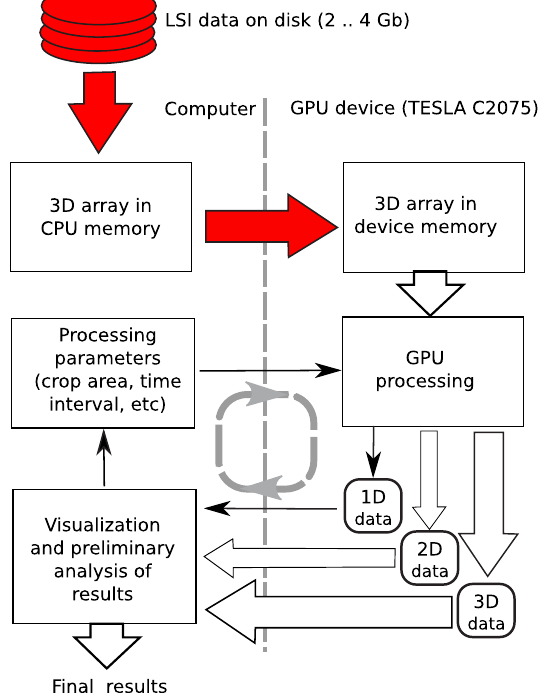
Fig. 1. A schematic illustration of GPU-based processing of large LSI data. The thicker arrows correspond to larger amount of data tra±c between CPU memory on motherboard and memory on GPU unit. Red color denotes the data exchange that is done once for each program